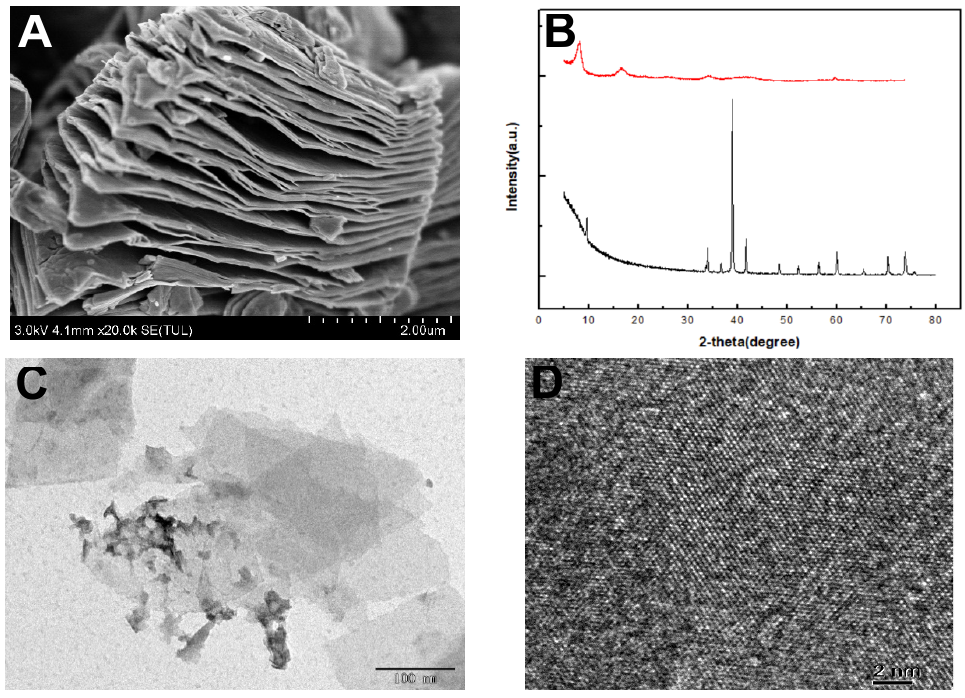
Figure 2. SEM ( A ), X-ray diffraction (XRD) patterns ( B ), TEM images ( C ), and HRTEM image ( D ) of the MXene Ti 3 C 2 T x.